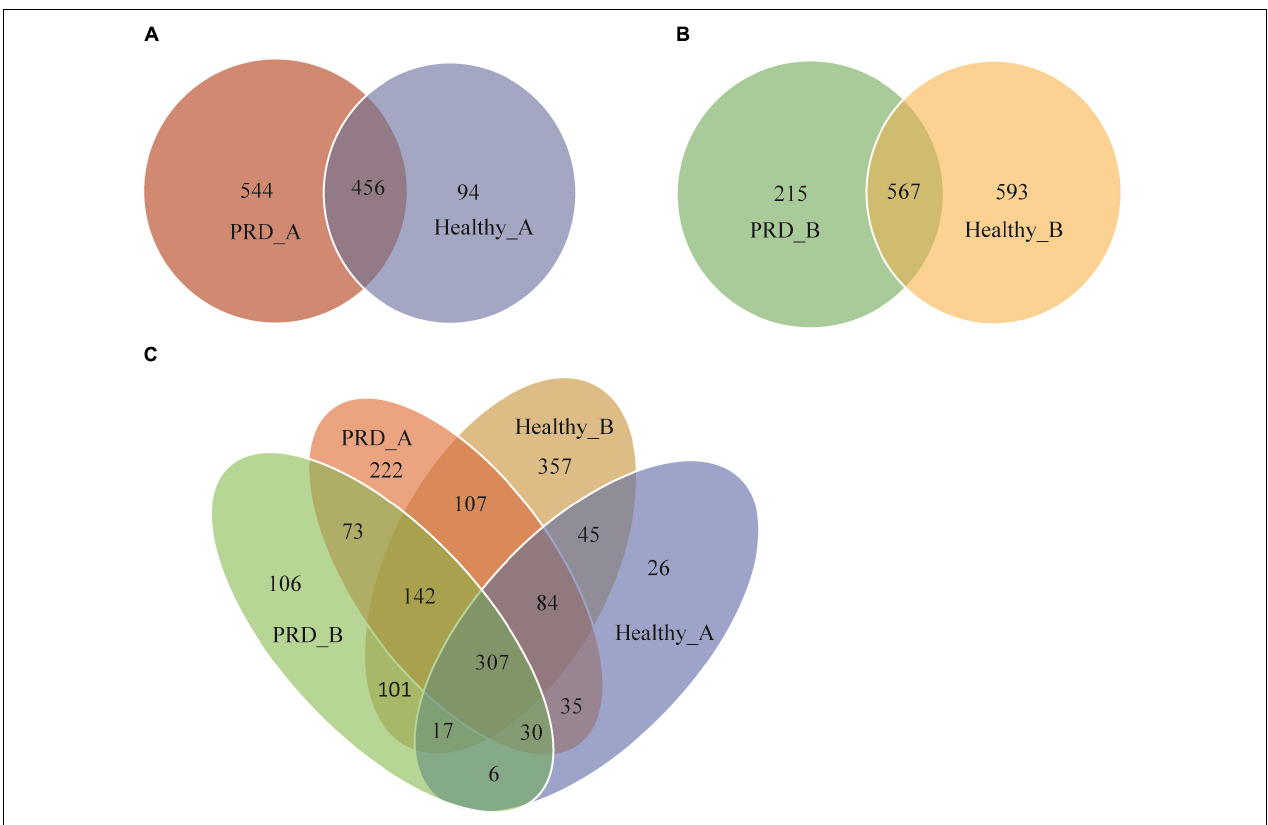
FIGURE 2 | Venn diagrams show the numbers of unique and shared OTUs between Porcine respiratory disease (PRD) and healthy groups in (A) farm A, (B) farm B, and (C) between all four groups.